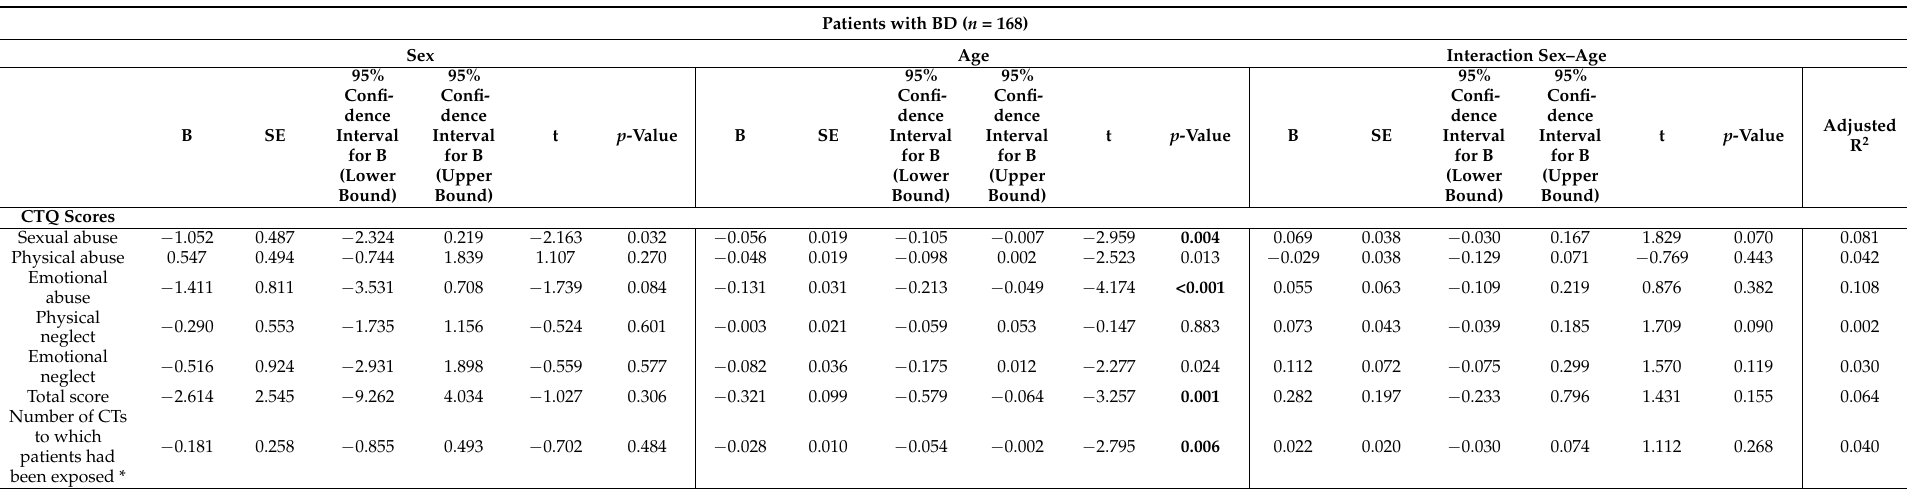
Table 4. Linear regression analysis in patients with